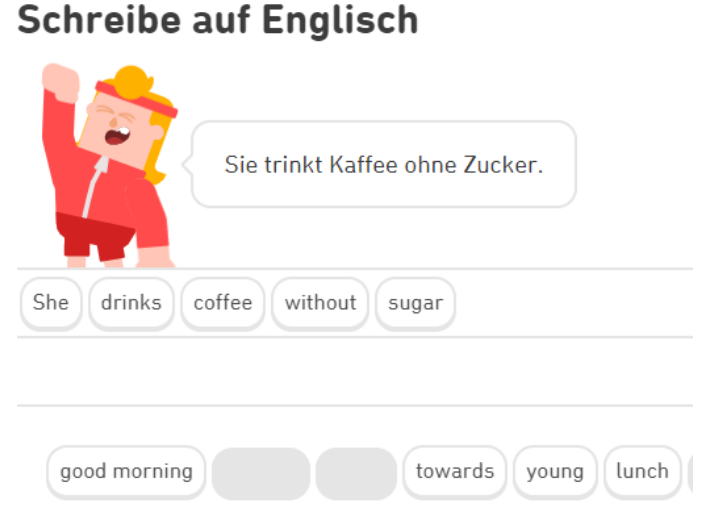
Figure 4: Assessment of a correctly completed writing